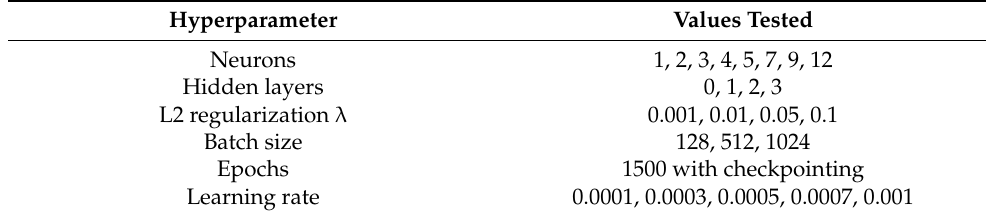
Table 1. Neural network model initial hyperparameter search specifications.